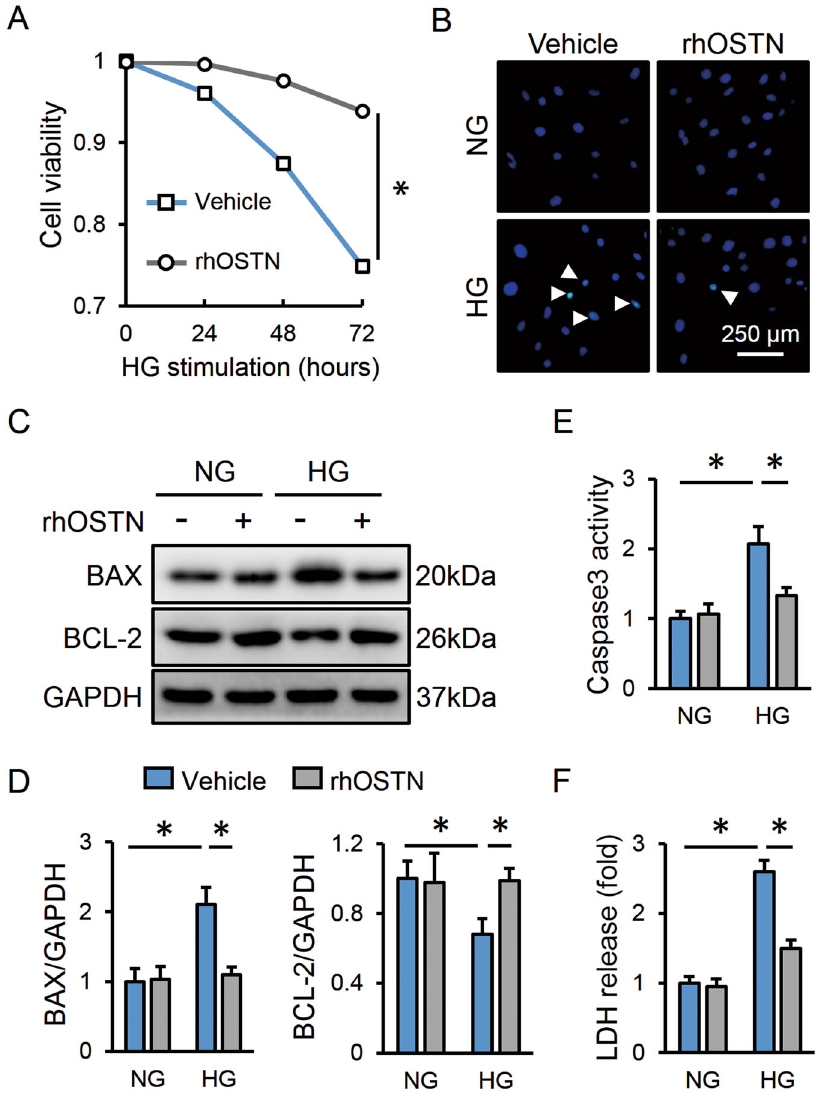
Fig. 3 OSTN prevents cardiomyocyte apoptosis and injury upon hyperglycemic stimulation in vitro. A Cell viability in neonatal rat cardiomyocytes with or without rhOSTN treatment after HG stimulation ( n = 5). B Representative TUNEL images in cardiomyocytes ( n = 6). White arrows indicate TUNEL-positive nuclei. C , D Representative western blot images and statistical results ( n = 6). E Caspase3 activity in cardiomyocytes ( n = 6). F LDH releases to the medium ( n = 6). Data represent mean ± SD. * P < 0.05 versus the matched (Figure S6C). These results support the conclusion that OSTN protects the cardiomyocytes from hyperglycemic damage via restoring proteasomal activity in vitro.